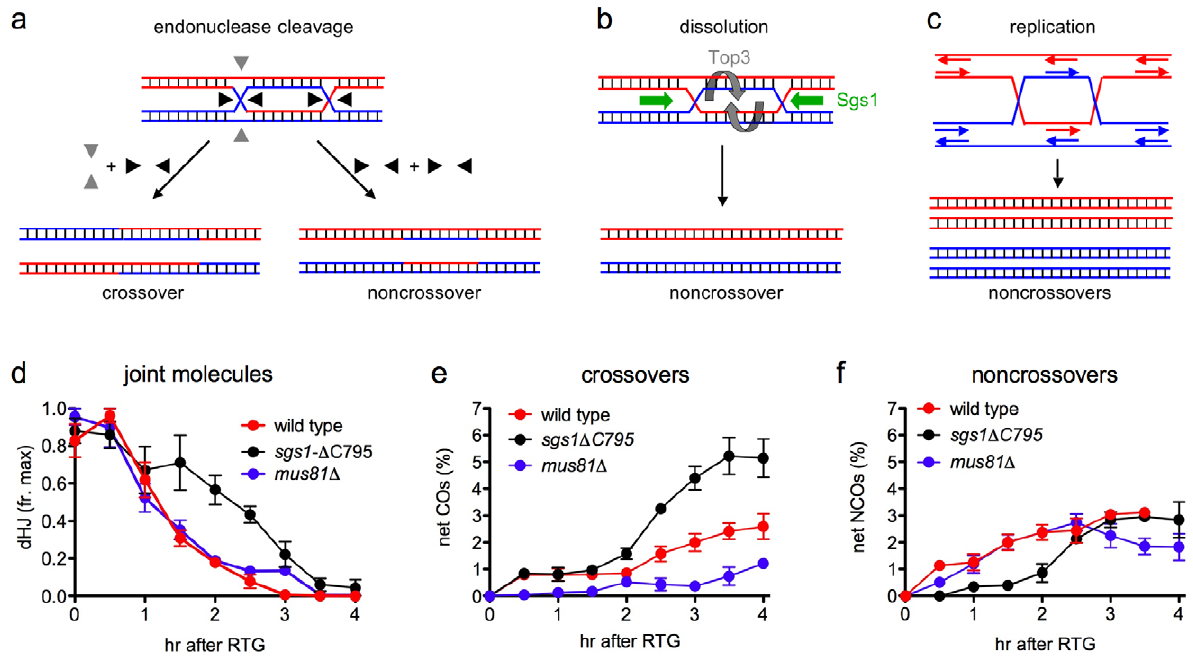
Figure 7. Modes of dHJ-JM resolution and summary of data. a. Resolution by junction cleavage [83]. Cleavage of both Holliday junctions in the same orientation (black arrows) yields noncrossovers; cleavage of the two junctions in orthogonal orientations (black and grey arrows) yields crossovers. For simplicity, only one of the two patterns for each type of cleavage is shown. b. Resolution by dissolution [31,32]. Helicase-driven convergent junction branch migration, coupled with topoisomerase-removal of superhelical stress, produces only noncrossovers. c. Resolution by replication produces only noncrossovers. d. Summary of JM resolution during RTG. Maximum JM levels in each individual experiment (3 for wild-type, 2 for sgs1- D C795 and mus81 D ) were set to 1. For sgs1- D C795 , 2-chromatid JM values were used, although similar results are obtained with total JMs (2-chromatid + multichromatid). Plotted values represent averages; error bars indicate standard error of the mean. e. Net CO production during RTG. CO levels at 0 hr (the time of RTG) were subtracted from each time-point value and plotted as in d. f. Net NCO production during RTG. NCO levels at 0 hr (the time of RTG) were subtracted from each time-point value and plotted as in d.